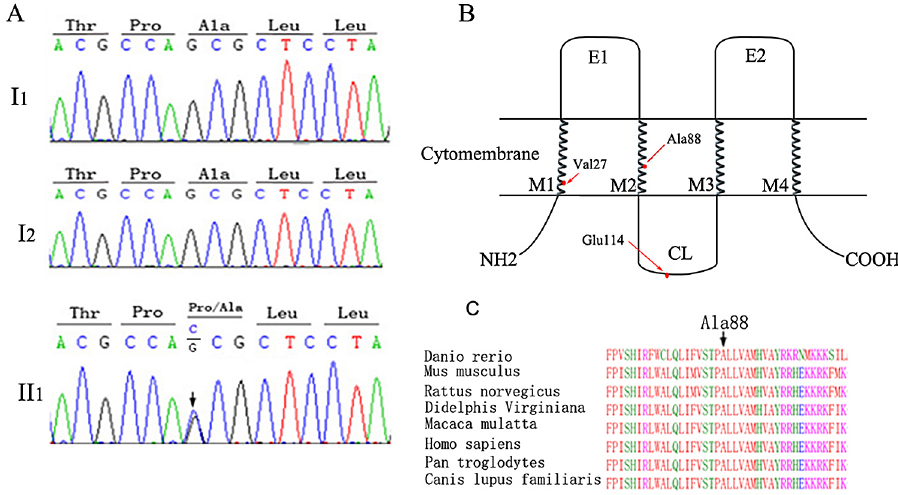
Figure 2. DNA and protein sequence analysis of GJB2. (A) The DNA sequence electropherograms (I1 father, I2 mother, II1 daughter) revealing wild-type sequence of the parents and de novo 262G to C transversion from their daughter (black arrow). (B) The schematic diagram of Cx26, where M1-M4 are transmembrane domains, E1-E2 are two extracellular loops, CL is intracellular loop, and NH2 and COOH is N- and C-cytoplasmatic termini respectively. The non-pathogenic c.79G>A (p.V27I), c.341A>G (p.E114G) is in both the M1 and intracellular loop. The c.262G>C (p. A88E) is in the M2 of Cx26. (C) The alignment of the Cx26 amino acid sequences among the different species. The alanine at codon 88 is highly